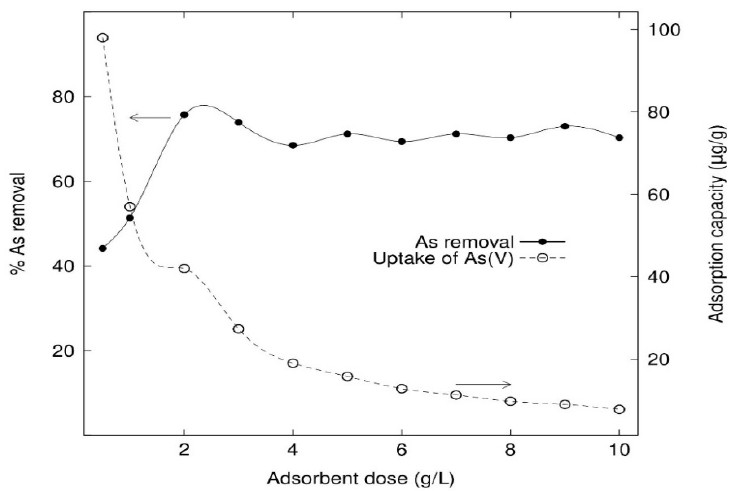
Figure 6. Effect of adsorbent dose on the adsorption of As(V) (Conditions: pH = 5, contact time 24 h, As concentration 100 µg/L and temperature 25 °C).